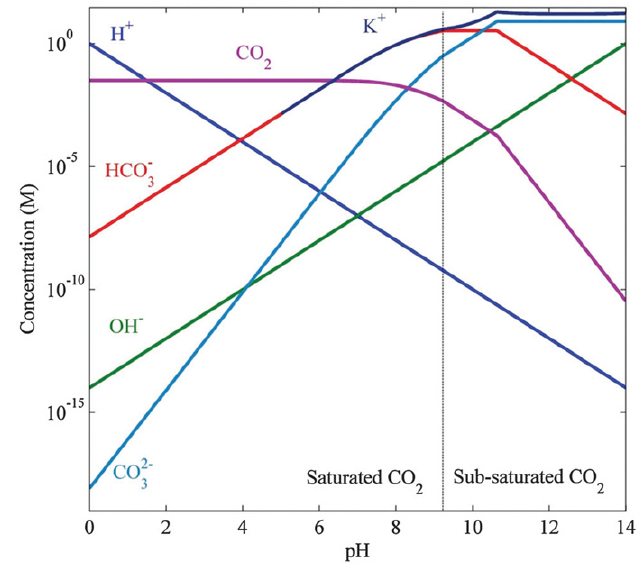
Figure 9. Concentrations of CO 2 , H + , OH − , HCO 3 − , CO 32 − , and K + as a function of pH of the KHCO 3 / CO 32 − electrolyte system at 25 ◦ C and a total pressure of 1 atm [77]. Copyright 2015, RSC.